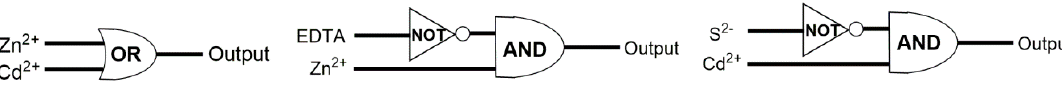
Figure 10. Logic schemes prepared from the binary inputs/outputs in the Truth tables [180]. Table 3. Truth table highlighting the binary inputs and the corresponding digital output [180].